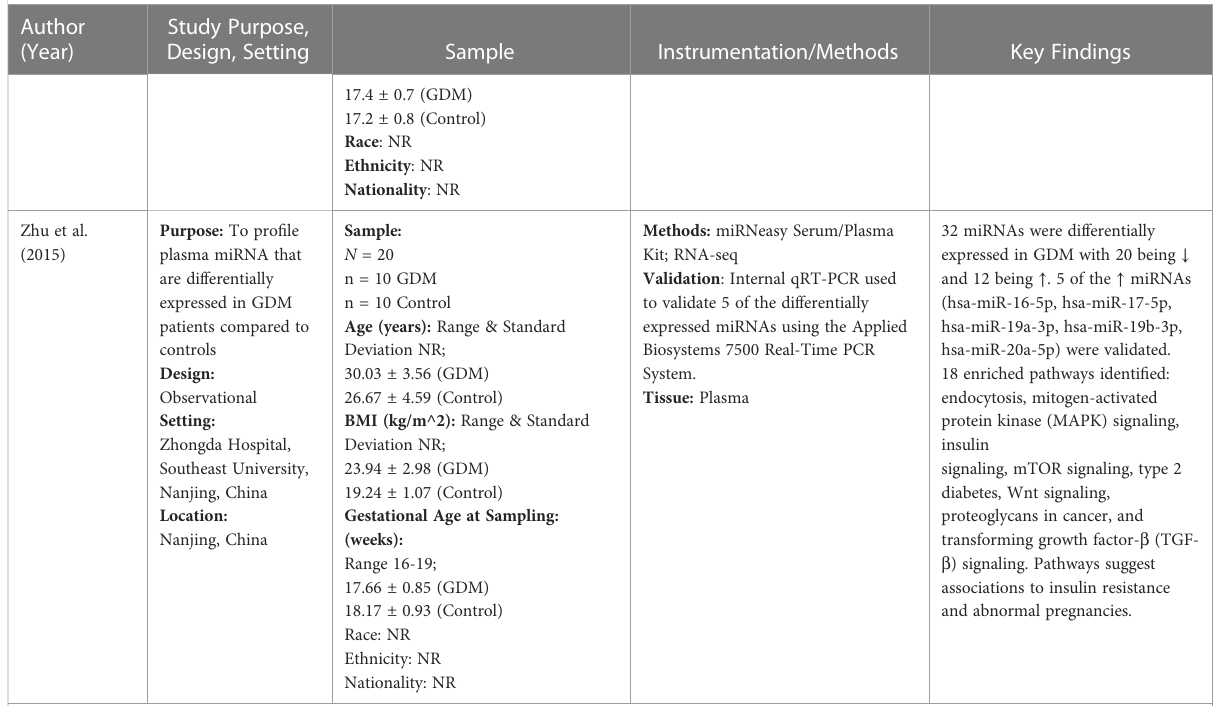
Table 1. The transcriptome pathways identi fi ed